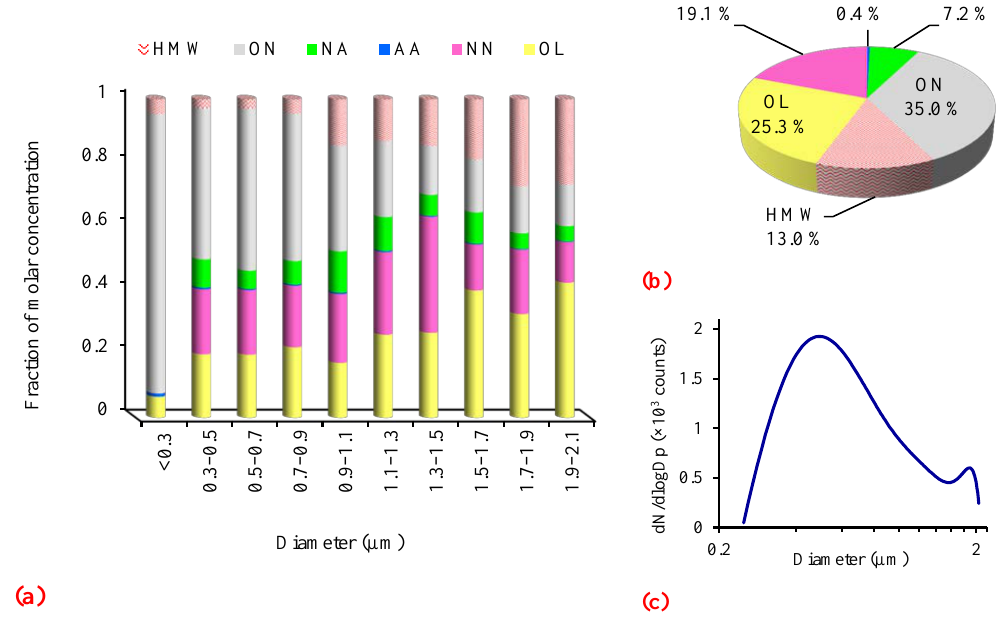
Figure 7. ATOFMS data analysis of (a) mole fraction of ozonolysed OL particles, under dry conditions, as a function of particle size; (b) total particle composition as given by mole fraction for all size fractions; and (c) corresponding size distribution of the aged OL aerosol measured by ATOFMS.